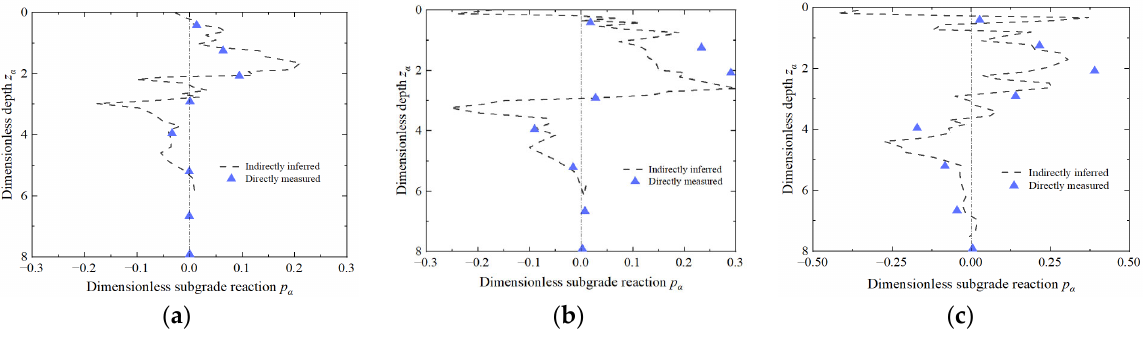
Figure 5. Comparisons between subgrade reaction profiles indirectly inferred from bending moment profiles and those directly measured by earth pressure cells. ( a ) Q 0 = 20 N; ( b ) Q 0 = 30 N; ( c ) Q 0 = 40 N.